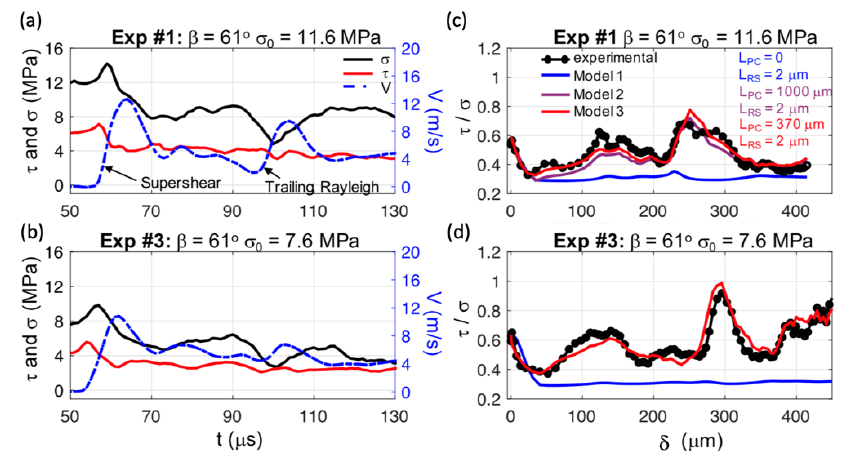
Fig. 4 . Experimental measurements showing the delayed response of the frictional shear resistance to rapid normal stress variations and fitting with friction models that capture this phenomenon (modified after Tal et al., 2020). ( a–b ) Time histories of τ (red), σ (black), and V (blue) near the free surface (for the location marked in the bottom right panel of Figure 3) for experiments labelled as 1 and 3. ( c ) Fitting of the measured effective friction τ / σ (experiment 1) for three models discussed in the text. The experimental data are best fit by friction model 3 with the Prakash – Clifton evolution distance that is two to three orders of magnitude larger than that of rate-and-state friction. ( d ) Comparison of the measured and predicted values of τ / σ for experiment 3 and friction model 3. The parameters of the friction model, which have been constrained using the data of experiment 1, coupled with the measured velocity time history of experiment 3, allow us to predict the nontrivial friction evolution in this experiment, as well as for various other experiments not show